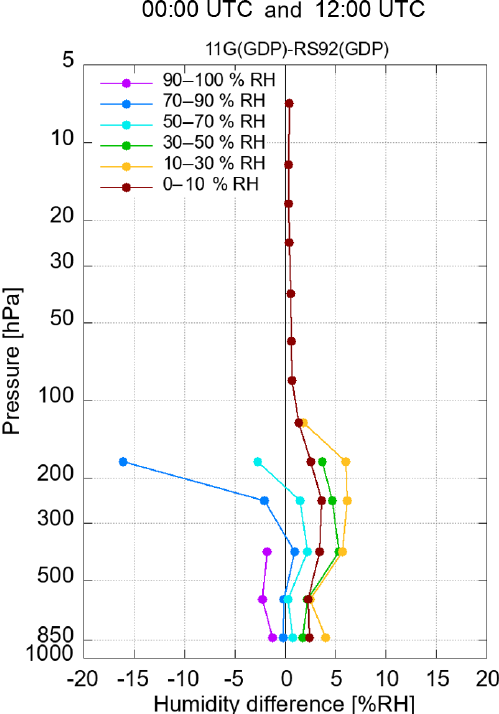
Figure 12. Profiles of mean differences (RS-11G GDP minus RS92 GDP) for all seasons and day and night combined for different RH ranges.